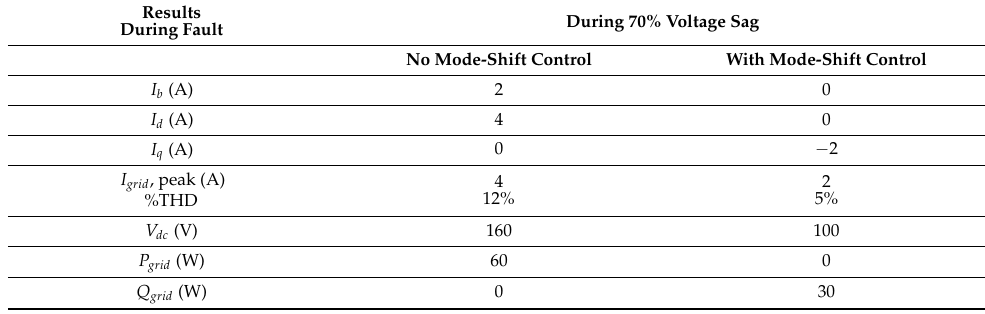
Table 5. Experimental performance